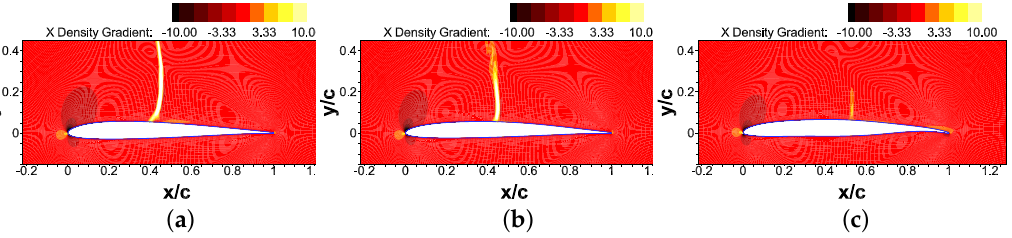
Figure 10. The gradient of density along the streamwise direction on the SD7003 airfoil: ( a ) baseline; ( b ) CST; and ( c )